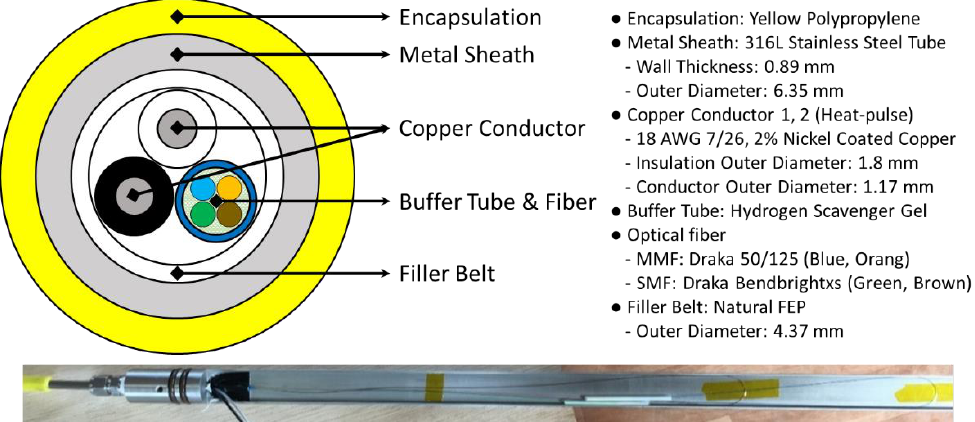
Figure 3. Schematic of fiber optic control line and specifications ( above ), and photo of turnaround sub for dual-ended configuration ( below ).